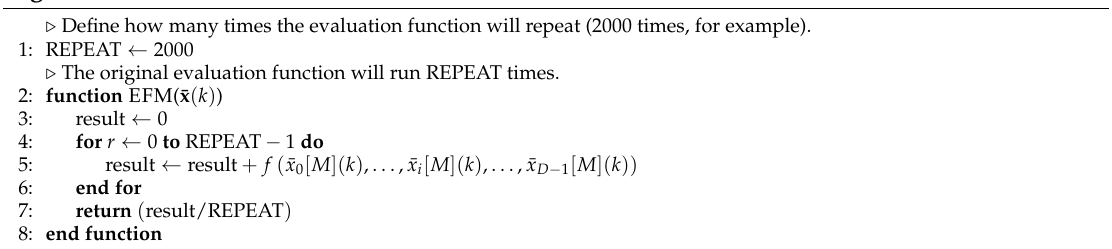
Algorithm 4 Redefinition of Evaluation Function to Become